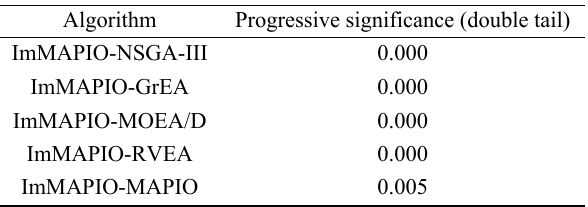
Table 6 Inspection results about the comparison results between the ImMAPIO and five